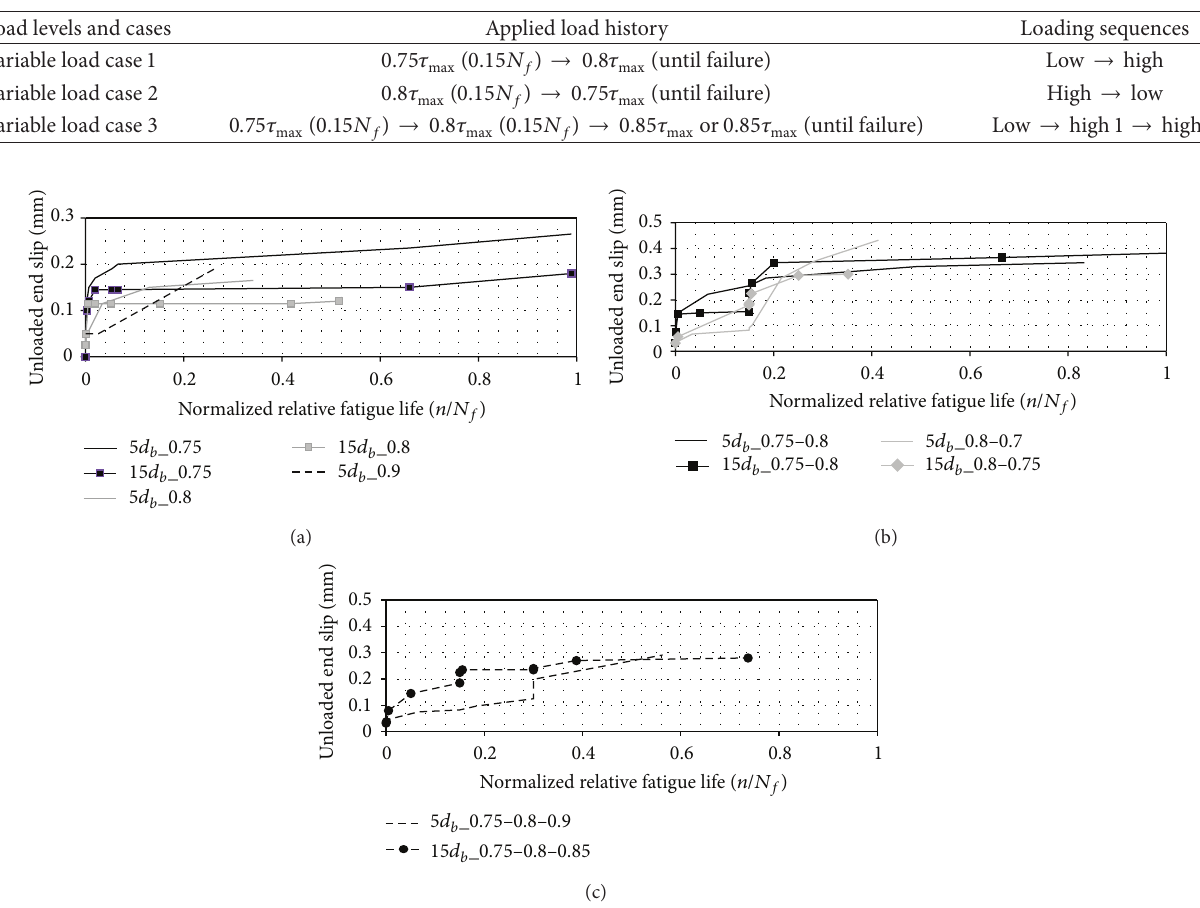
Figure 13: Cumulative end-slip increase according to the relative fatigue life.